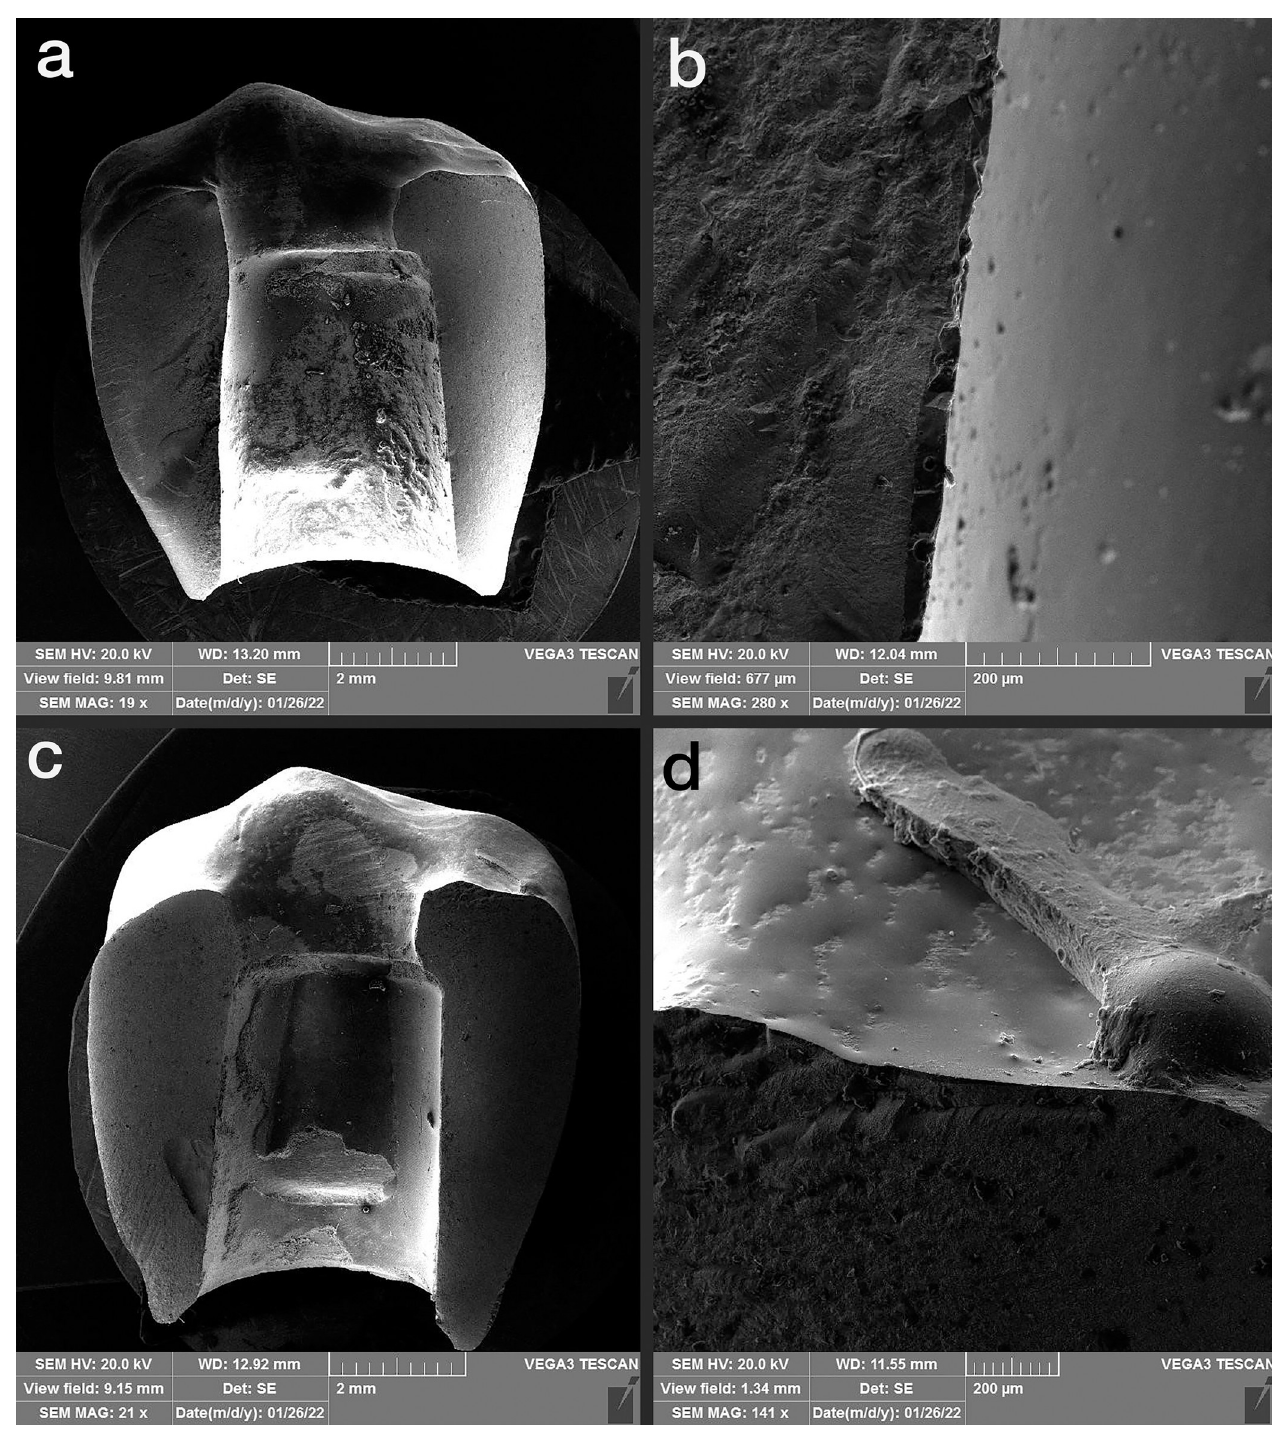
Fig 4. SEM images of monolithic zirconia. a and b: thermocycled, c and d: non-thermocycled. https://doi.org/10.1371/journal.pone.0270527.g004 fracture regardless of thermocycling. In the thermocycled PFM subgroup, most of the fractures (71%) were in the veneering porcelain; in non-thermocycling subgroups, 43% of failures were in the interface and 57% were in the veneering porcelain. ( Table 3 ).